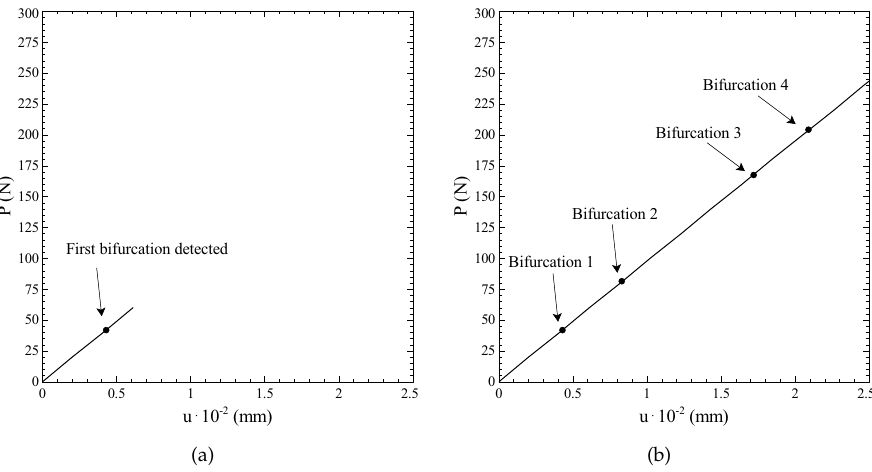
Figure 7. Primary equilibrium path: ( a ) detection of the first critical point, ( b ) full equilibrium